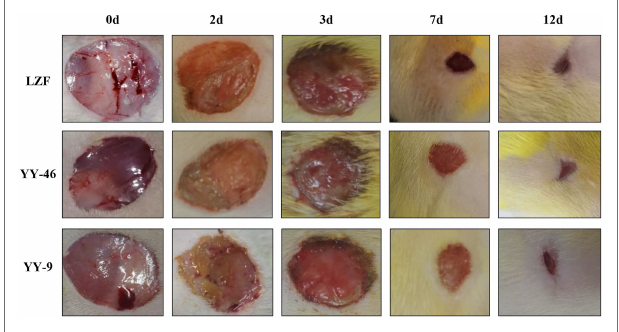
FIGURE 9 | Equivalence evaluation of pharmacodynamics in rats.